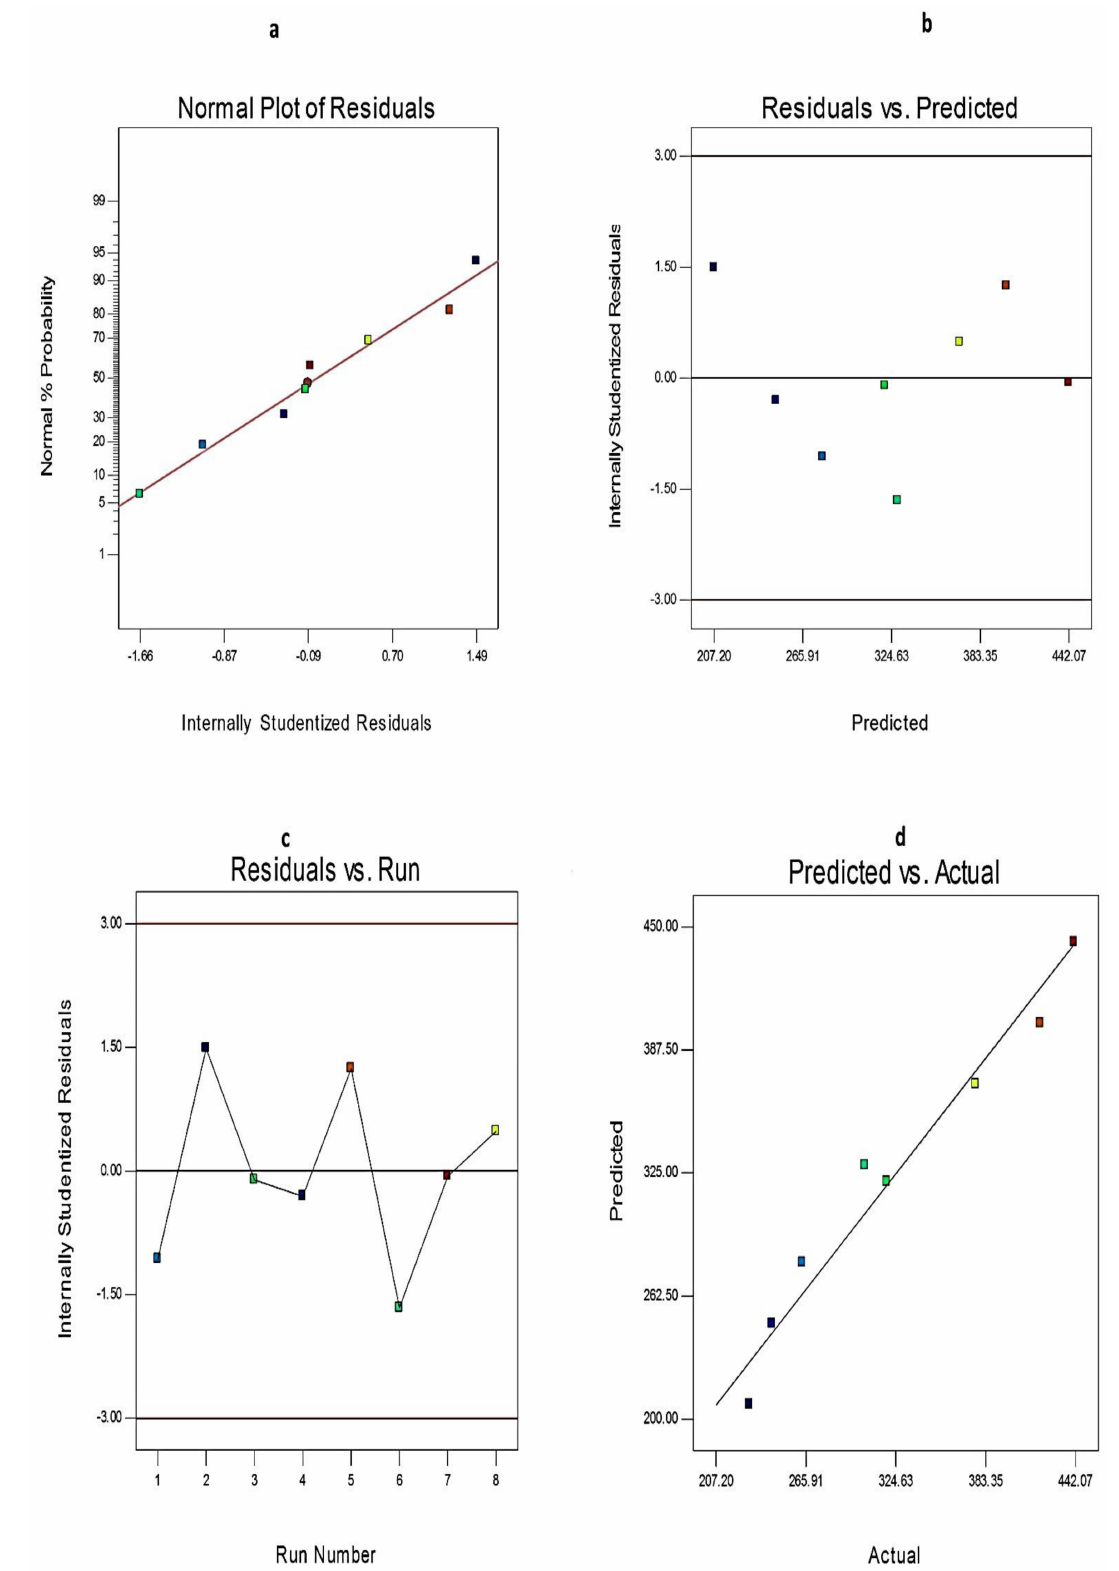
Figure 3. The diagnostic plots for PS of EGCG-loaded spanlastics ( a ) plot of normal % probability versus the internally studentized residuals, ( b ) plot of the internally studentized residuals versus the predicted values, ( c ) plot of the internally studentized residuals versus the run number, and ( d ) plot of the predicted versus the actual values. Abbreviation: PS, particle size of EGCG-loaded